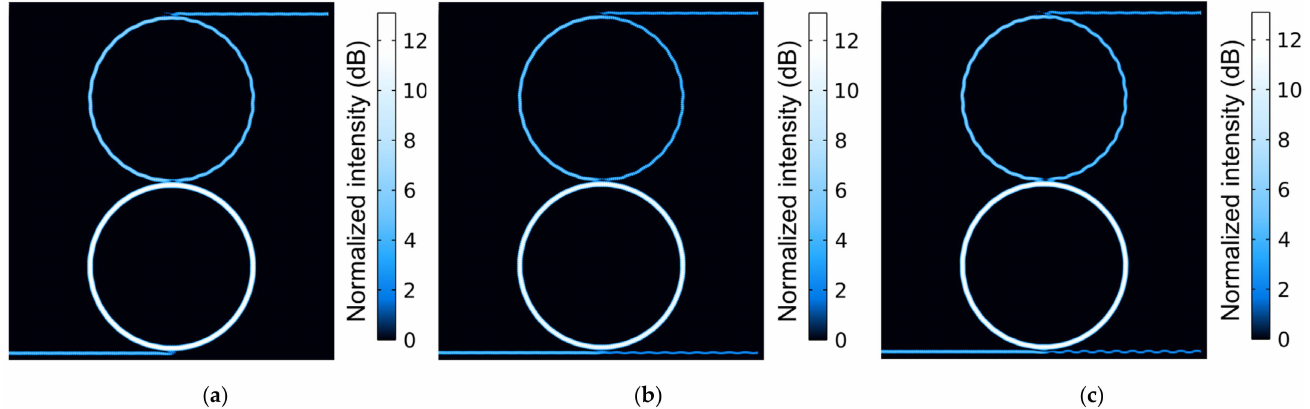
Figure 4. The intensity distribution of system under different initial coupling states obtained by COMSOL Multiphysics. ( a – c ) show the intensity distribution of the system operating at the critical- coupling, under-coupling, and over-coupling conditions at the initial detuning, respectively.